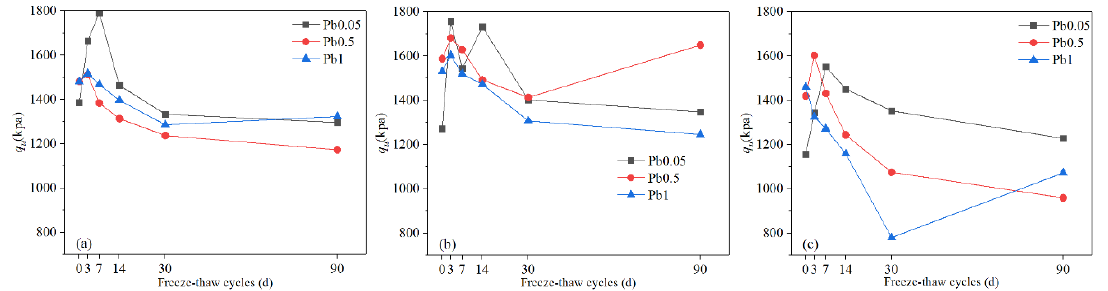
Figure 3. The UCS of Pb-CSCSs with the same compound binder and different contaminant contents: ( a ) C2.5S5F5; ( b ) C5S2.5F2.5, and ( c ) C5S5.